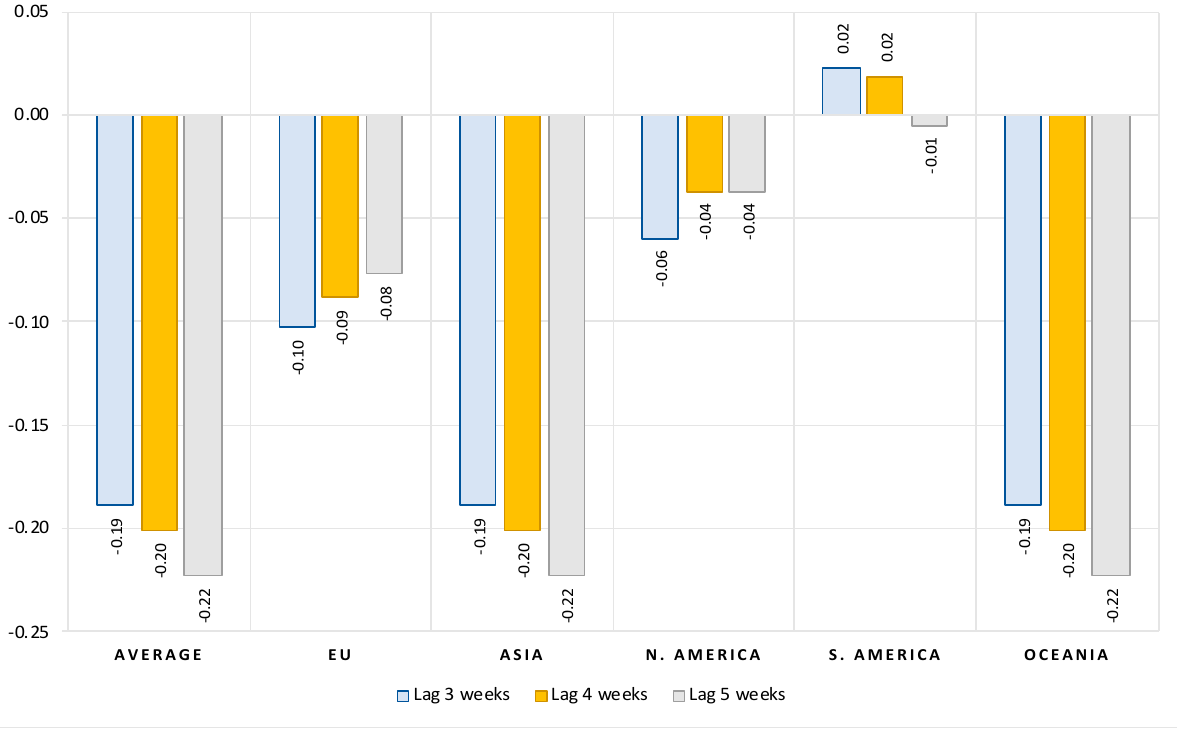
Figure 6. Impact of vaccination rate on number of new deaths, all countries. Notes: Figure contains the estimated elasticities of the per-million number of new deaths with COVID to vaccination rate obtained by estimating the model (2). See Table A6 in the Appendix for the full results.